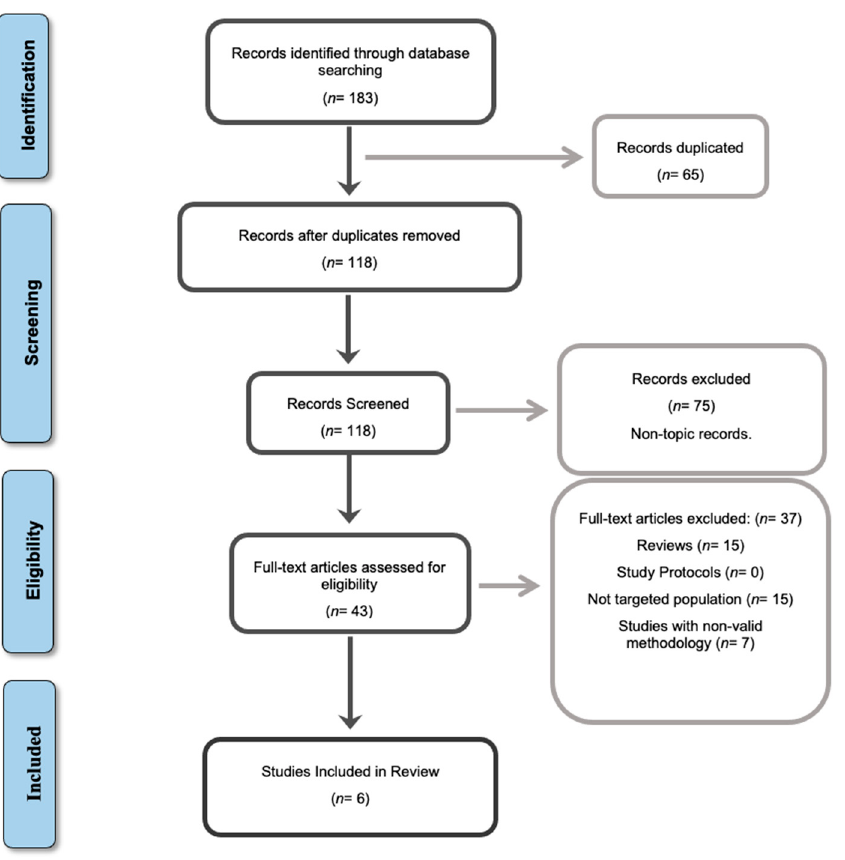
Figure 1. Information flowchart of the different phases of the systematic review, according to the Preferred Reporting Items for Systematic Reviews and Meta-Analyses (PRISMA) guidelines.